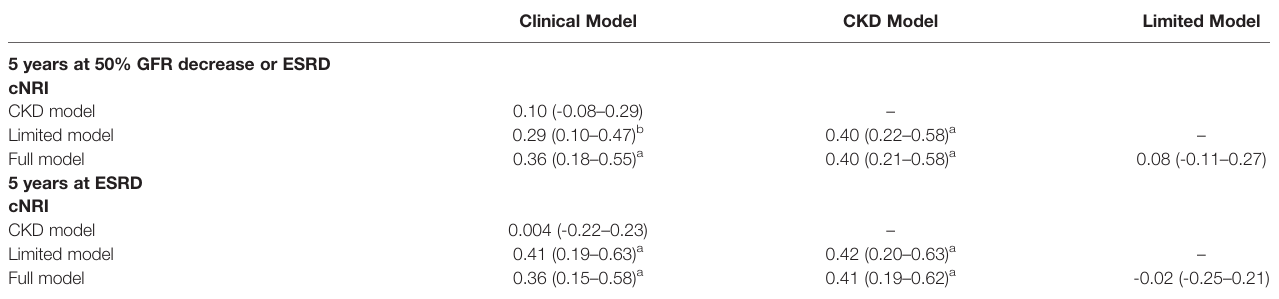
TABLE 3 | For total group, comparison of models ’ discrimination performance in the validation cohort for predicting the risk for two outcomes (ESRD or 50% GFR decreased; ESRD) at 5 years after biopsy.